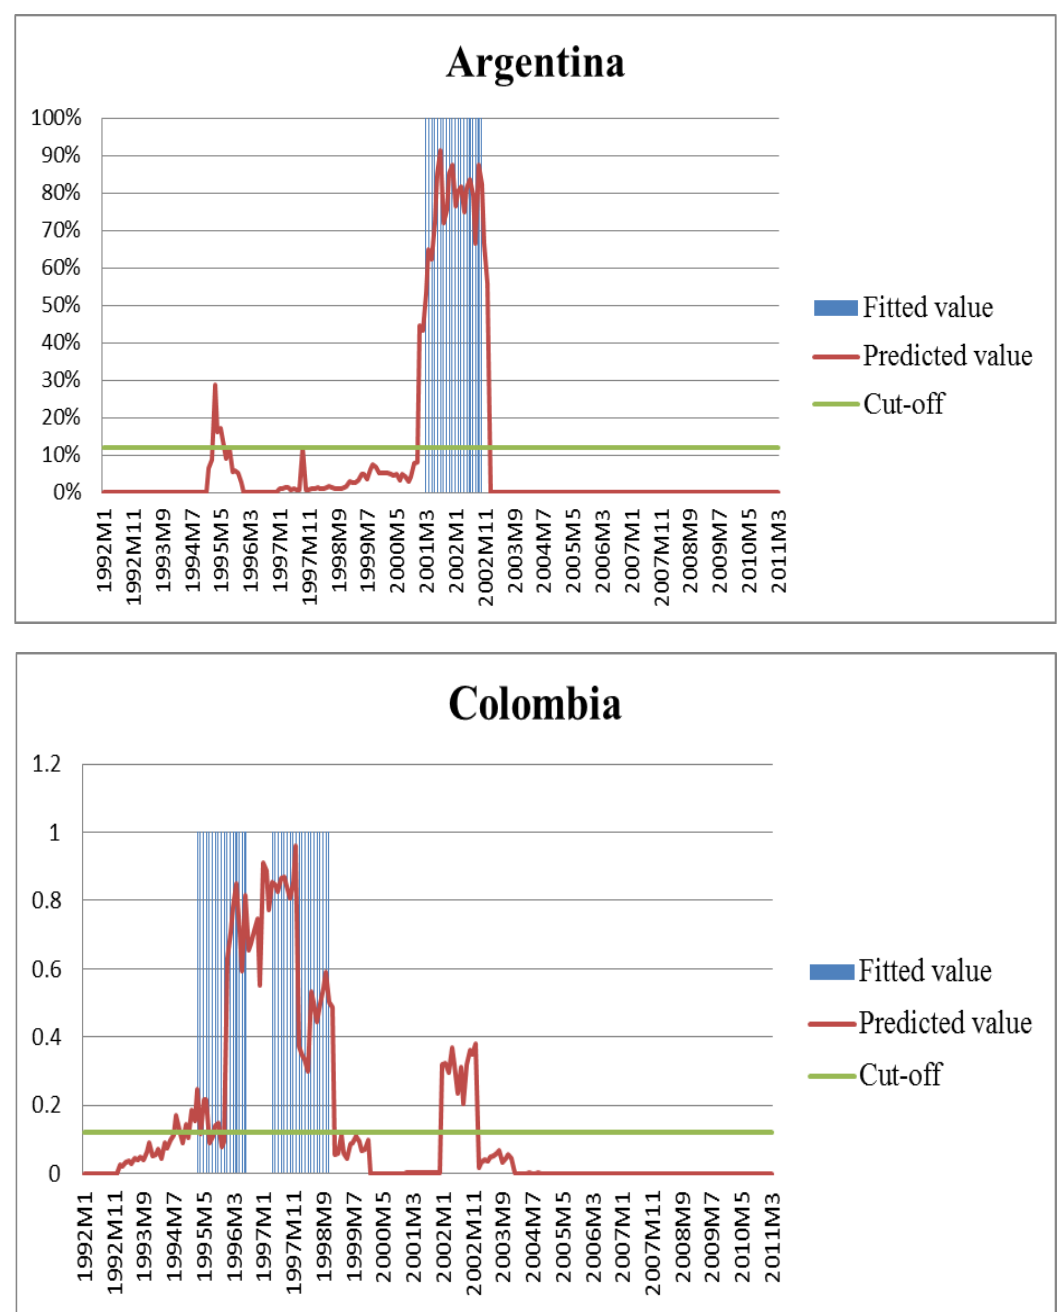
Figure 6. Actual and predicted values of four Latin American countries.